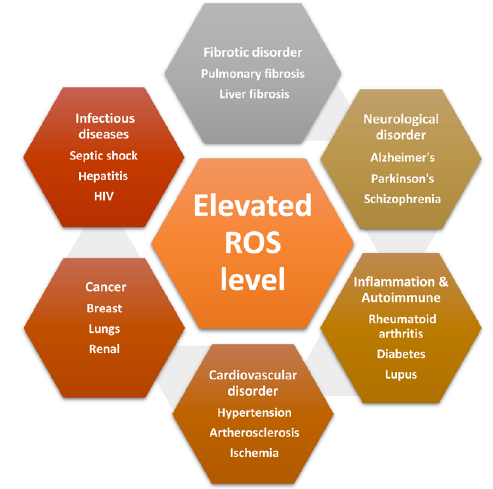
Figure 1. ROS dysregulation contributes to various pathological conditions Homeostasis of ROS and redox